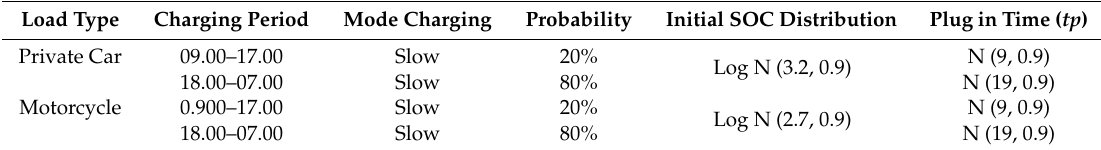
Table 3. Residential EV charging probabilistic model.